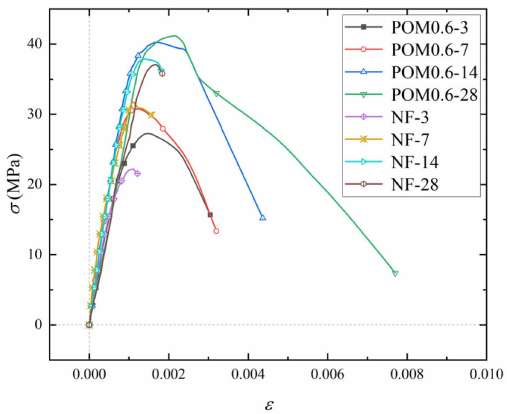
Figure 24. Stress–strain curve of SWSSC specimens with different ages.